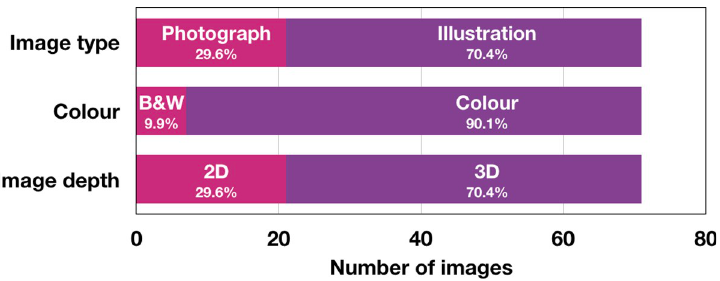
Fig 2. Attributes and format of SARS-CoV-2 coronavirus images. These images (N = 71) were available online at the start of the COVID-19 pandemic [5]: 29.6% of the images were photographs and 70.4% were illustrations; 9.9% were in black and white and 90.1% were in colour; and 29.6% were in two dimensions, while 70.4% were in three dimensions.